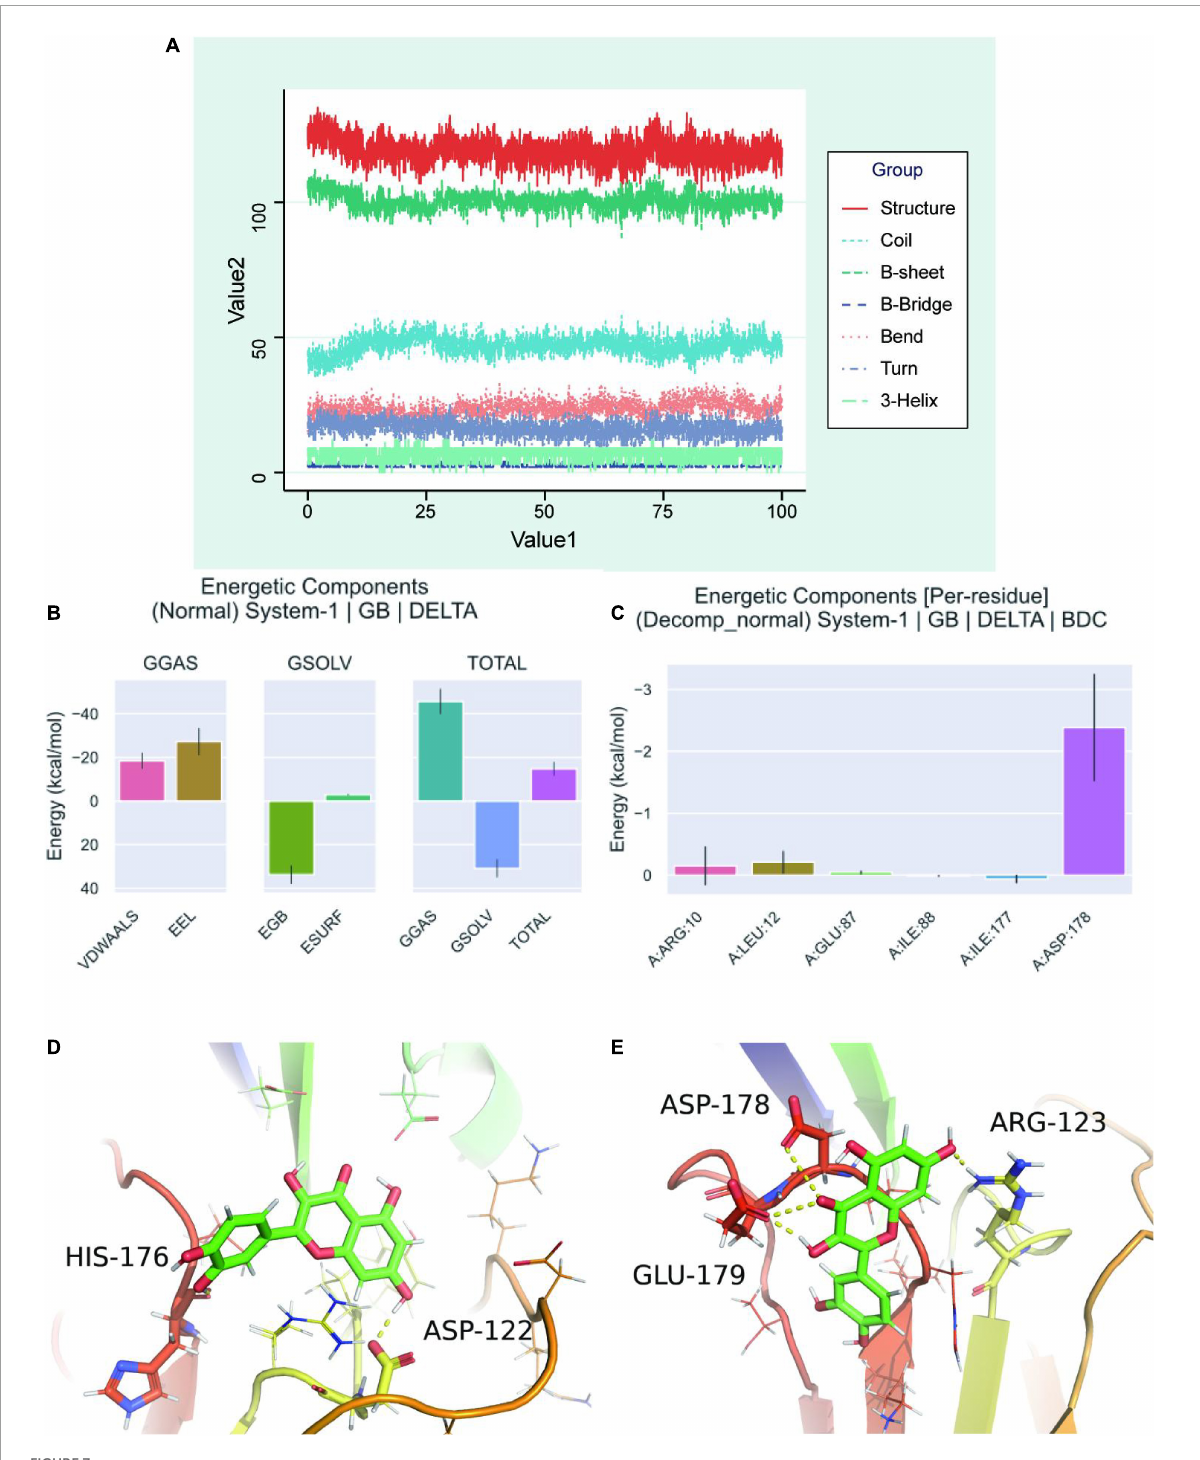
FIGURE7 Molecular dynamics simulation analysis of secondary structure. (A) A graph showed the change of individual secondary structures of proteins over time in MDS system. (B) Free energy of binding between protein-ligand complexes. VDWAALS, “van der Waals energy”; Eel, “Electrostatic energy”; EGB, “Polar solvation energy”; ESURF, “Non-polar solvation energy”; GGAS, “Total gas phase free energy”; GSOLV, “Total solvation free energy”; TOTAL, The free energy item: “GSOLV + GGAS.” (C) Relationship between each contact residue with binding energy. (D) Binding of quercetin-VCAM1 complex at critical frame of 22 ns. (E) Binding of quercetin-VCAM1 complex at critical frame of 73.4